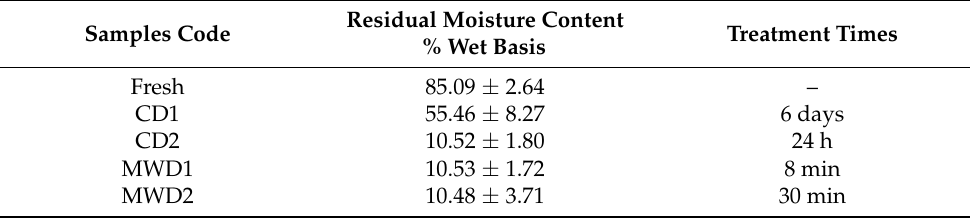
Table 2. Samples code and note on selected operative conditions of applied drying methods. Samples Code